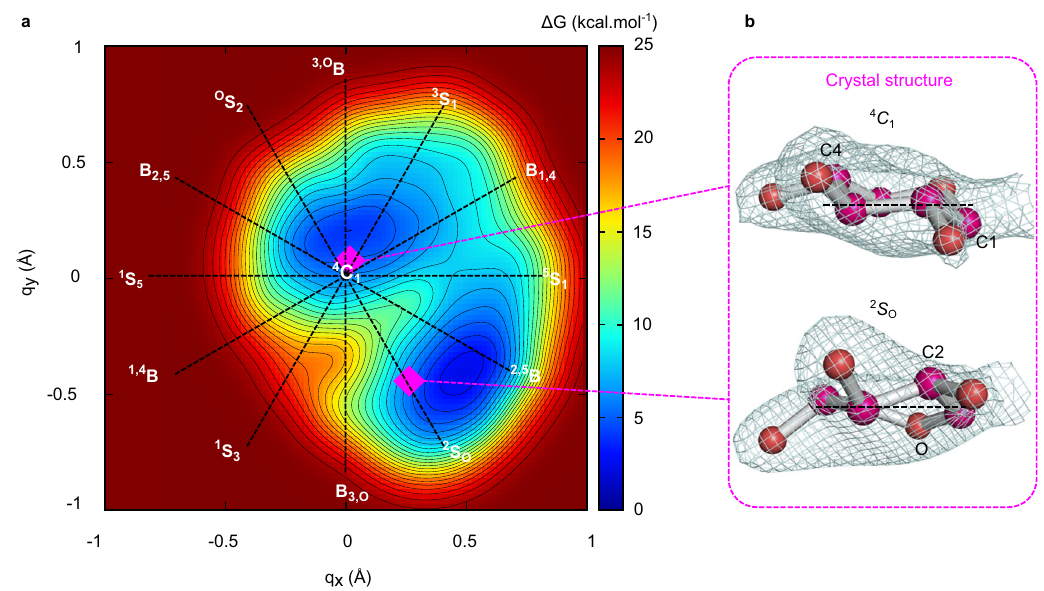
Fig. 6 Conformations adopted by the xylopyranosyl ring at the − 1 subsite of XacGH43_1 active site. a FEL of xylopyranose in the − 1 subsite of XacGH43_1 active-site obtained by ab initio metadynamics. The two conformations (found in the xylotriose crystal complex) are represented as purple squares. Isolines represent intervals of 1.0 kcal mol − 1 . b Representation of the xylosyl residue at the − 1 subsite in the xylotriose crystal complex, with 2F o -F c electron density map contoured at 1.7 σ , after re fi nement. Source data are provided as a source data fi